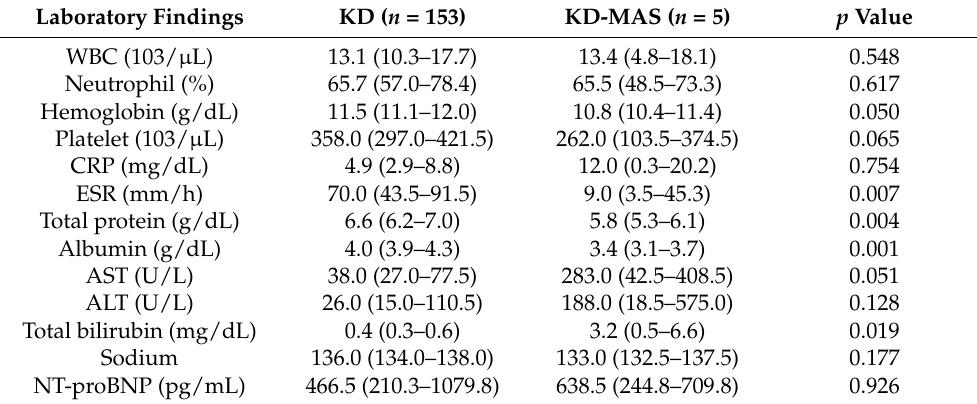
Table 2. Conventional laboratory findings of two groups on the first day of admission. Laboratory Findings